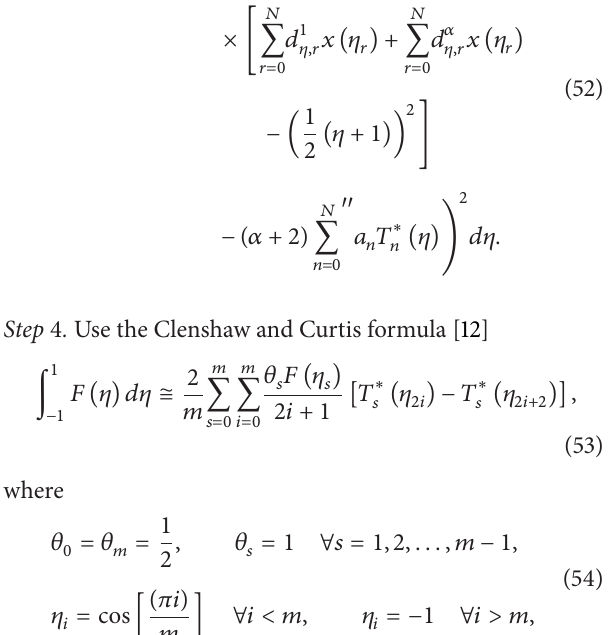
Figure 5: Exact and approximate